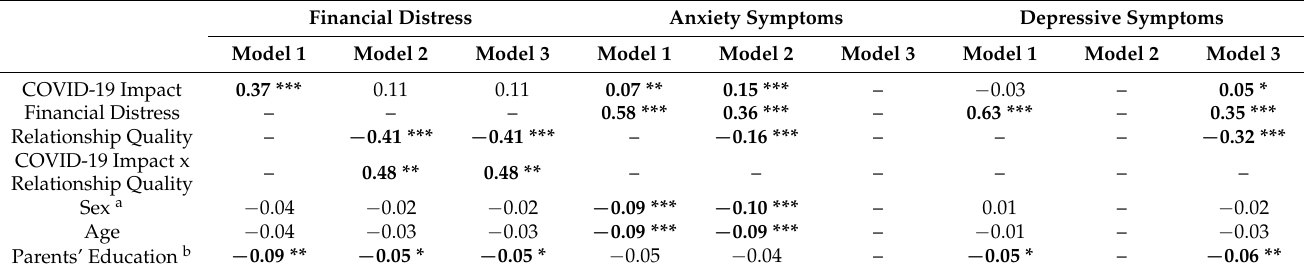
Table 2. Standardized direct